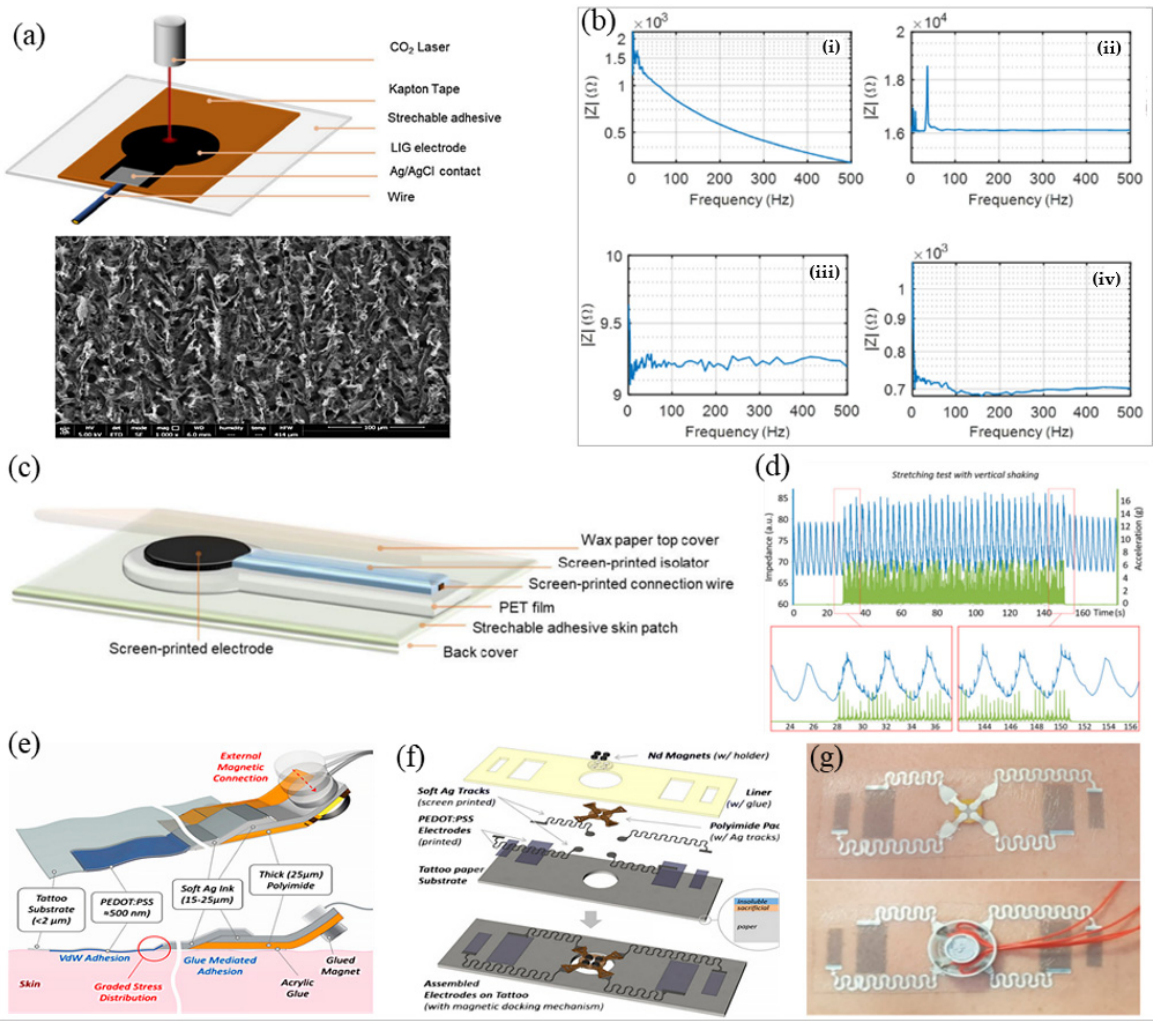
Figure 6. Partial summary of electrical physiology electrode preparation strategies based on printed electronics technology. ( a ) LIG electrode and its SEM. ( b ) Impedance measurement for ( i ) commercial electrodes, ( ii ) carbon electrodes, ( iii ) silver electrodes and ( iv ) LIG electrode. ( c ) Multilayer structure used for each electrode from screen printed electrodes. ( a – c ) are reproduced with permission from [6]. Copyright 2020, The Authors. ( d ) Example of impedance signal during 2 min of “shaking”, showing that the sensor output is scarcely affected by motion artifacts. ( e ) Connection schematic section for TTE electrode. ( f ) Schematic representation of design and geometry of PEDOT:PSS electrodes and interconnections for transthoracic impedance measurements. ( g ) TTE electrode released on the chest of a subject (top) and the same docked through a magnetic connector used for signal acquisition. ( d–g ) are reproduced with permission from [103]. Copyright 2021, The Authors.